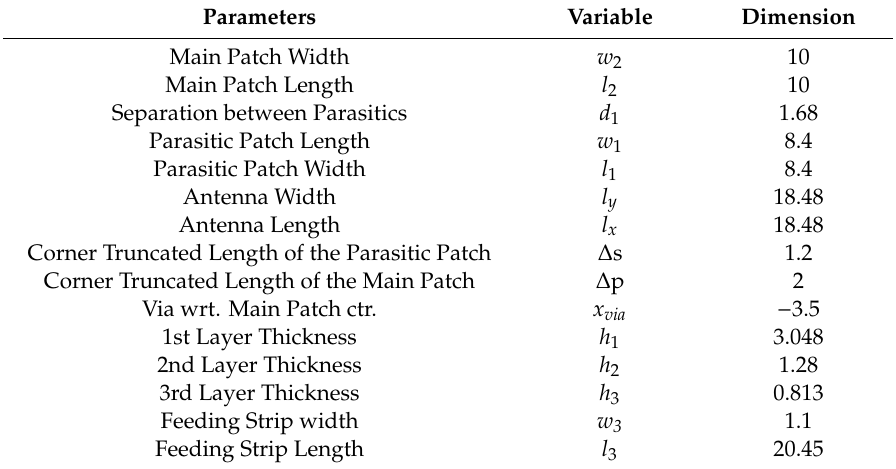
Table 1. Wideband MIMO antenna optimal design variables (all sizes in